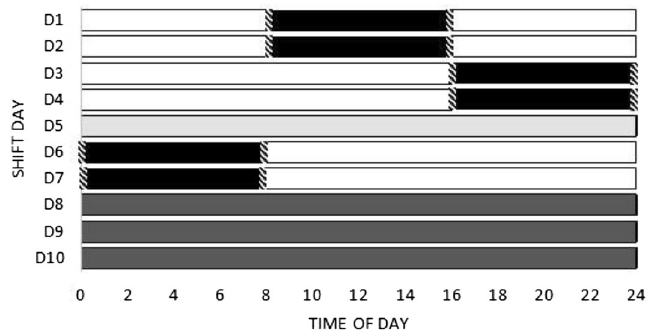
Figure 1. Shift schedule days. Black = work periods. Hatched = PVT tests moments. White = free time on workdays. Light grey = 24 h of rest. Dark grey = free